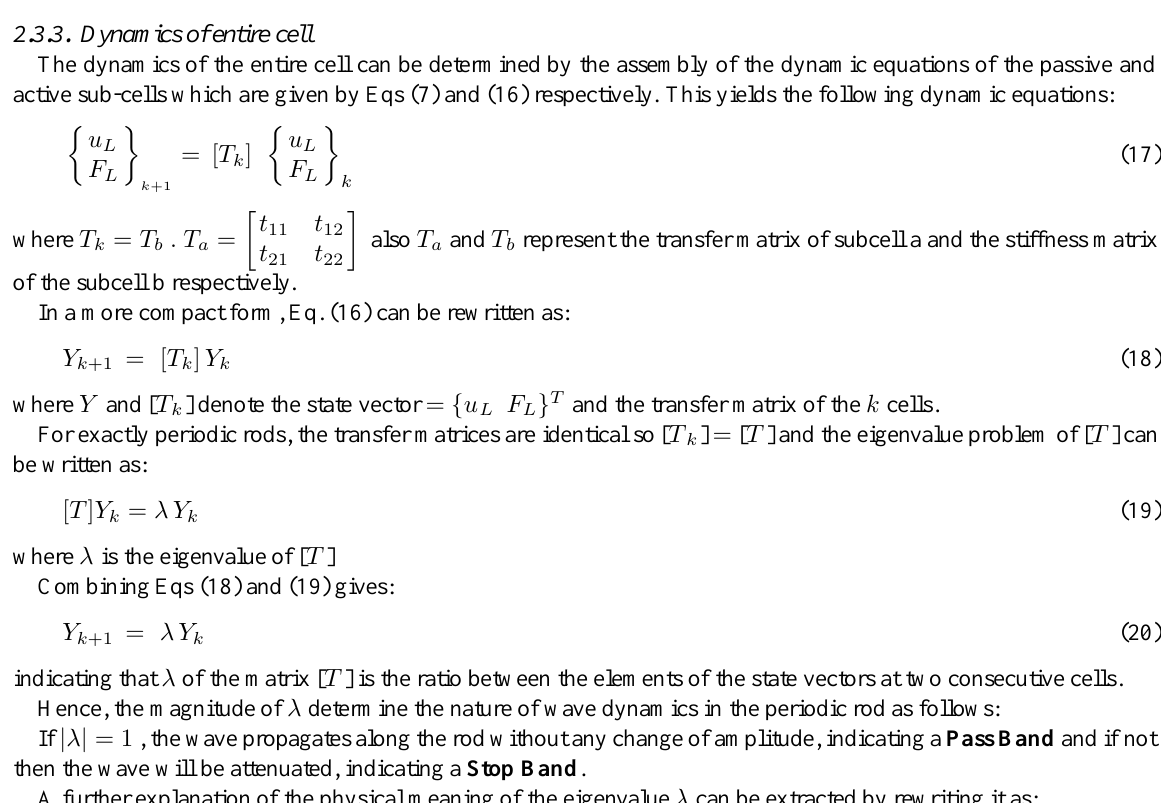
Fig. 4. One-dimensional periodic